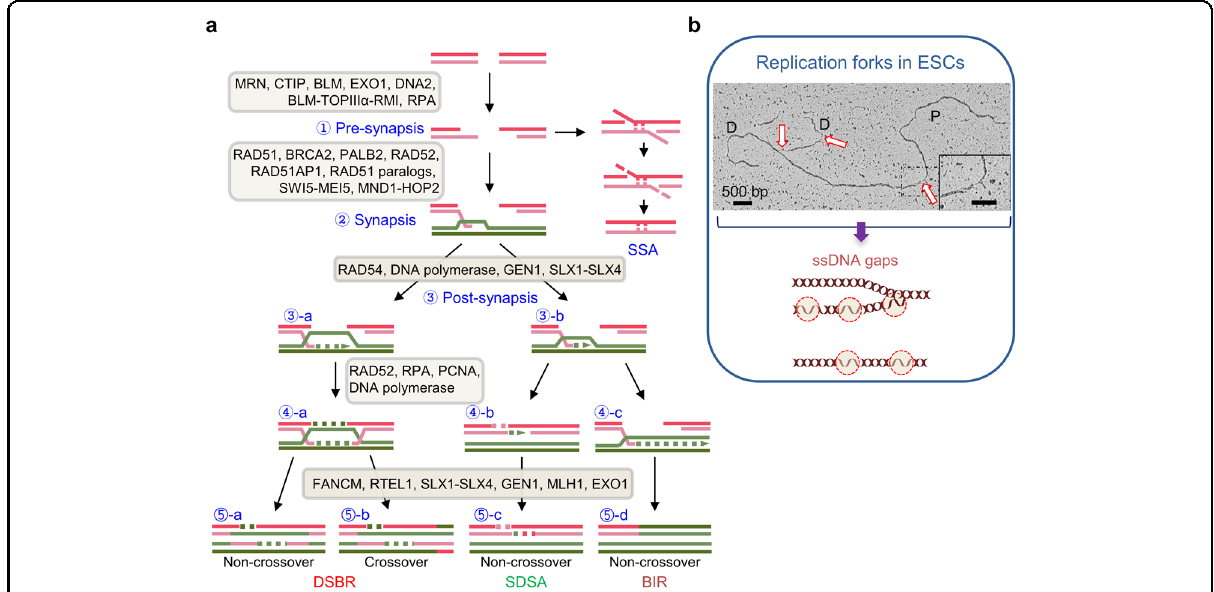
Fig. 3 Homologous recombination promotes genome integrity in ESCs. a Homologous recombination (HR)-mediated DSB repair pathways. HR pathways can be generally classi fi ed into three stages: presynapsis, synapsis, and postsynapsis. In presynapsis, single-stranded tails of DSB ends are generated by nucleases (step 1). During synapsis, invasion of the DNA strand by Rad51 cofactors leads to the formation of a D-loop (step 2). At least three distinct pathways, double-strand break repair (DSBR), break-induced replication (BIR), and synthesis-dependent strand annealing (SDSA), share the D-loop intermediate. In DSBR (steps 3a-5a and 5b), DSB ends are engaged, leading to double-Holliday junction (dHJ) formation. A dHJ is a substrate for separation into either noncrossover or crossover products. In SDSA (steps 3b, 4b and 5c), the leader strand is displaced from the D-loop and reannealed with the single-stranded tail, forming noncrossover products. In BIR (steps 3b, 4c, and 5d), the D-loop is assembled into a complete replication fork and copies the entire distal arm of the chromosome. b Electron microscopy images of replication forks in mESCs (modi fi ed from Ahuja et al. 3 ). Arrows indicate ssDNA gaps. D, daughter DNA strand; P, parental DNA strand. The scale bar in the inset is 200